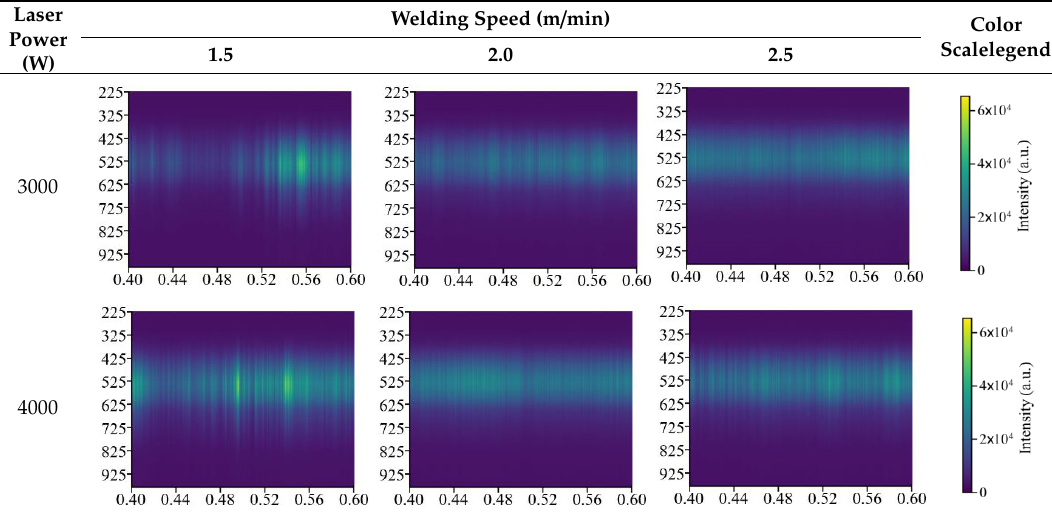
Table 4. Color-coded images of spectrum at a gap of 0.8 mm according to the laser power and welding speed: in each image, the horizontal axis is time (s), the vertical axis is wavelength (nm), and intensity is mapped in color (color scale: Viridis, data from [28]). Laser (W)